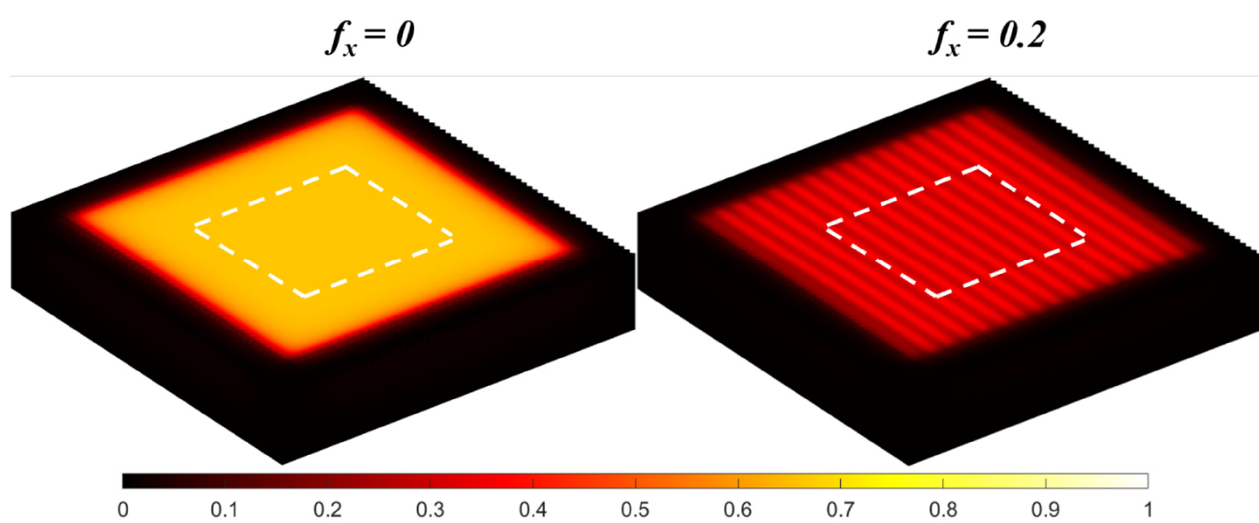
Figure 4. Normalized surface fluence from both a zero-spatial frequency illumination and an illumination of f x = 0.2 mm −1 and zero-phase. The field of view for the detected 2D images is shown by the white bounding box.